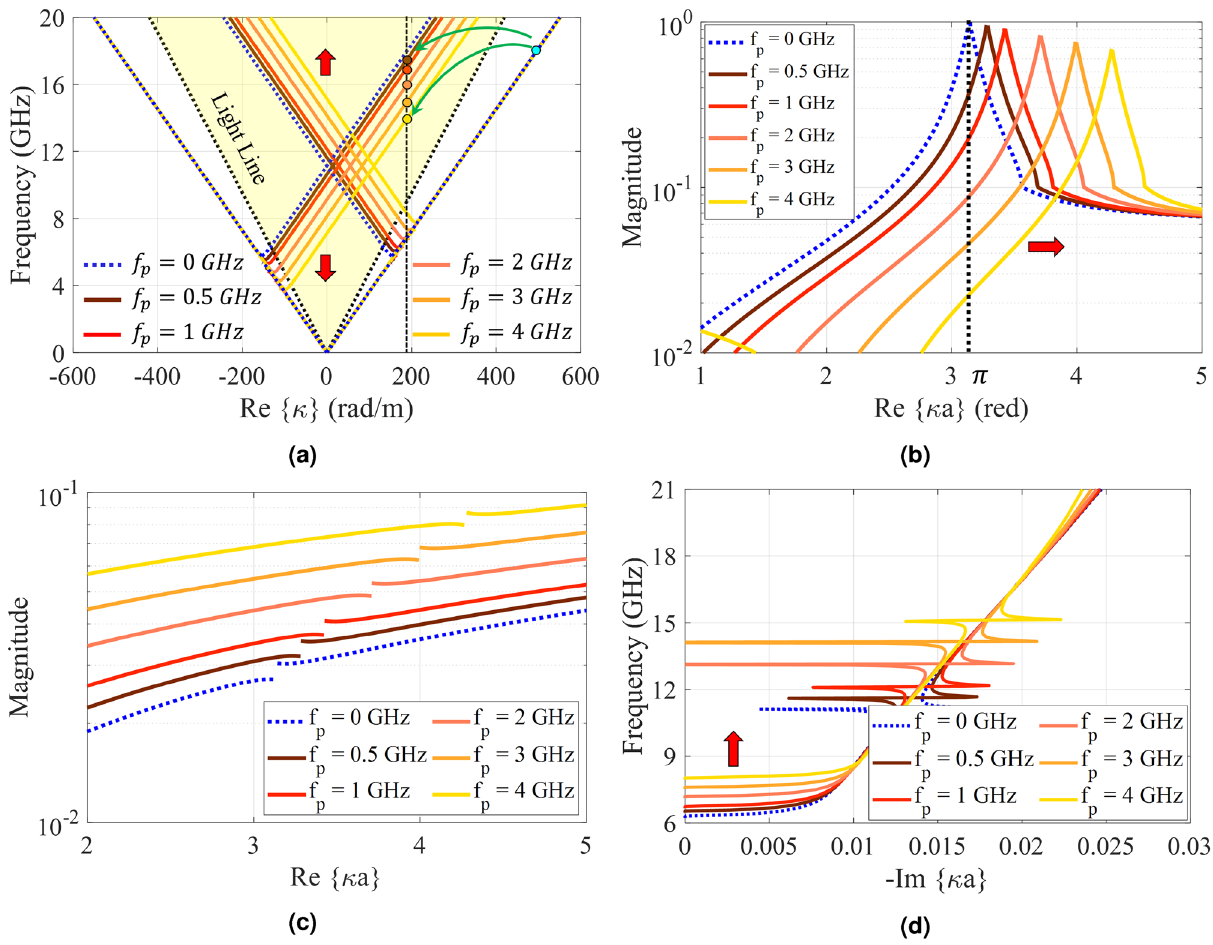
Figure 11. Analytical results of the proposed hologram for different values of f p . ( a ) Dispersion diagram. ( b ) Normalized magnitude of higher (-1)-indexed Floquet modes ( | H − 1 / H 0 | ) versus κ a . ( c ) Normalized magnitude of higher (+1)-indexed Floquet modes ( | H + 1 / H 0 | ) versus κ a . ( d ) Attenuation